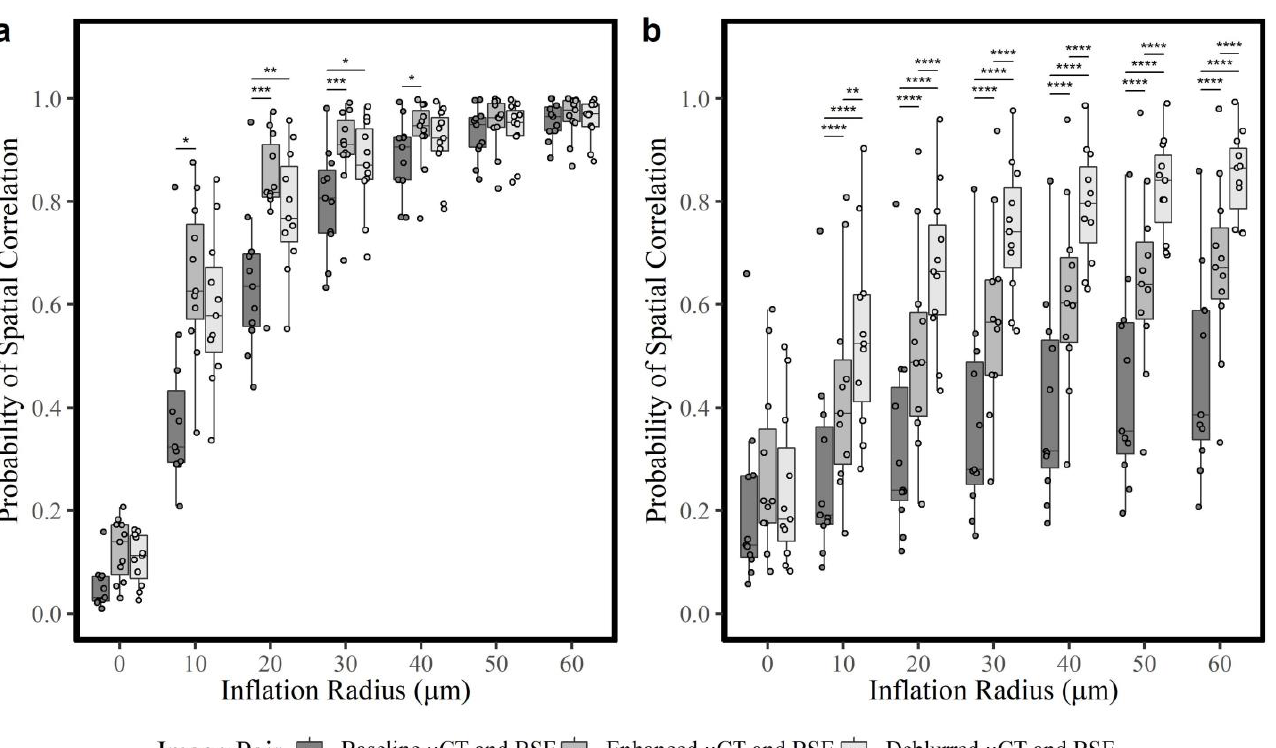
Figure 5. Probability of spatial correlation of BaSO 4 -labeled pixels in paired µCT (baseline, enhanced, and deblurred) and BSE images at six inflation radii. ( a ) the probability that BaSO 4 -labeled pixels in a µCT image (baseline, enhanced, or deblurred) fall within some radius of BaSO 4 -labeled pixels in a BSE image; ( b ) the probability that BaSO 4 -labeled pixels in a BSE image fall within some radius of BaSO 4 -labeled pixels in a µCT image (baseline, enhanced, or deblurred). The data presented are from eleven sagittal BSE slides from rat L1 vertebrae (healthy = 5, osteolytic = 3, mixed = 3). * p < 0.05, ** p < 0.01, *** p < 0.001, **** p < 0.0001, Tukey pair-wise comparison.